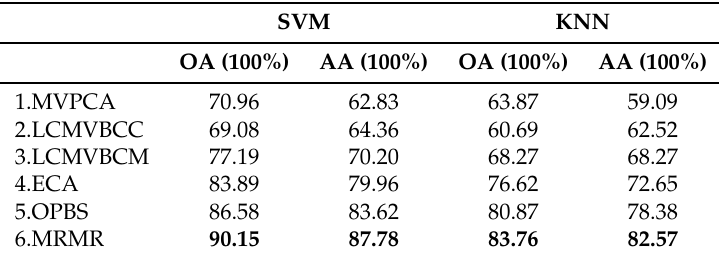
Table 3. Overall Classification Accuracies and Average Classification Accuracies of Using the Ten Bands Selected from the Pavia University Dataset. (The bold denotes the best result).